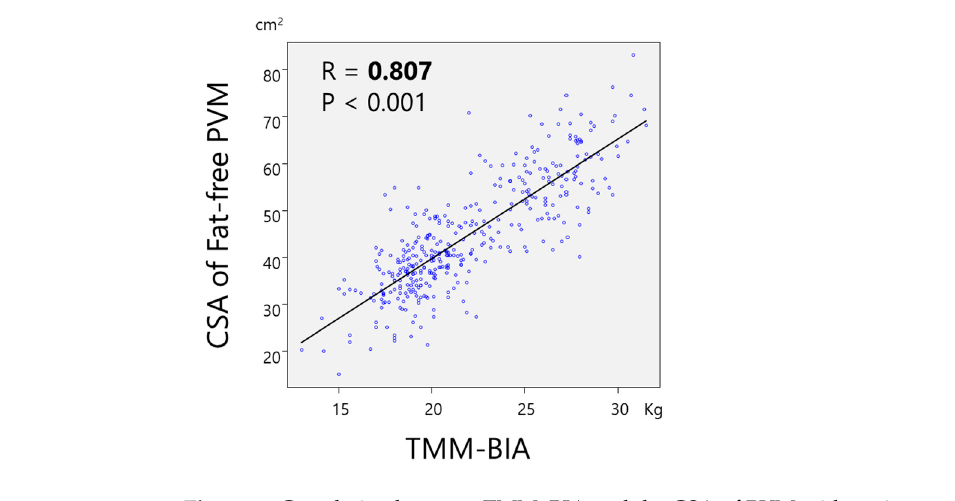
Figure 3. Correlation between TMM–BIA and the CSA of PVM without intramuscular fat. There was a significant correlation between TMM–BIA and the CSA of fat-free PVM with r = 0.807. TMM–BIA, trunk muscle mass measured by bioelectrical impedance analysis; CSA, cross-sectional area; PVM, paravertebral muscles.